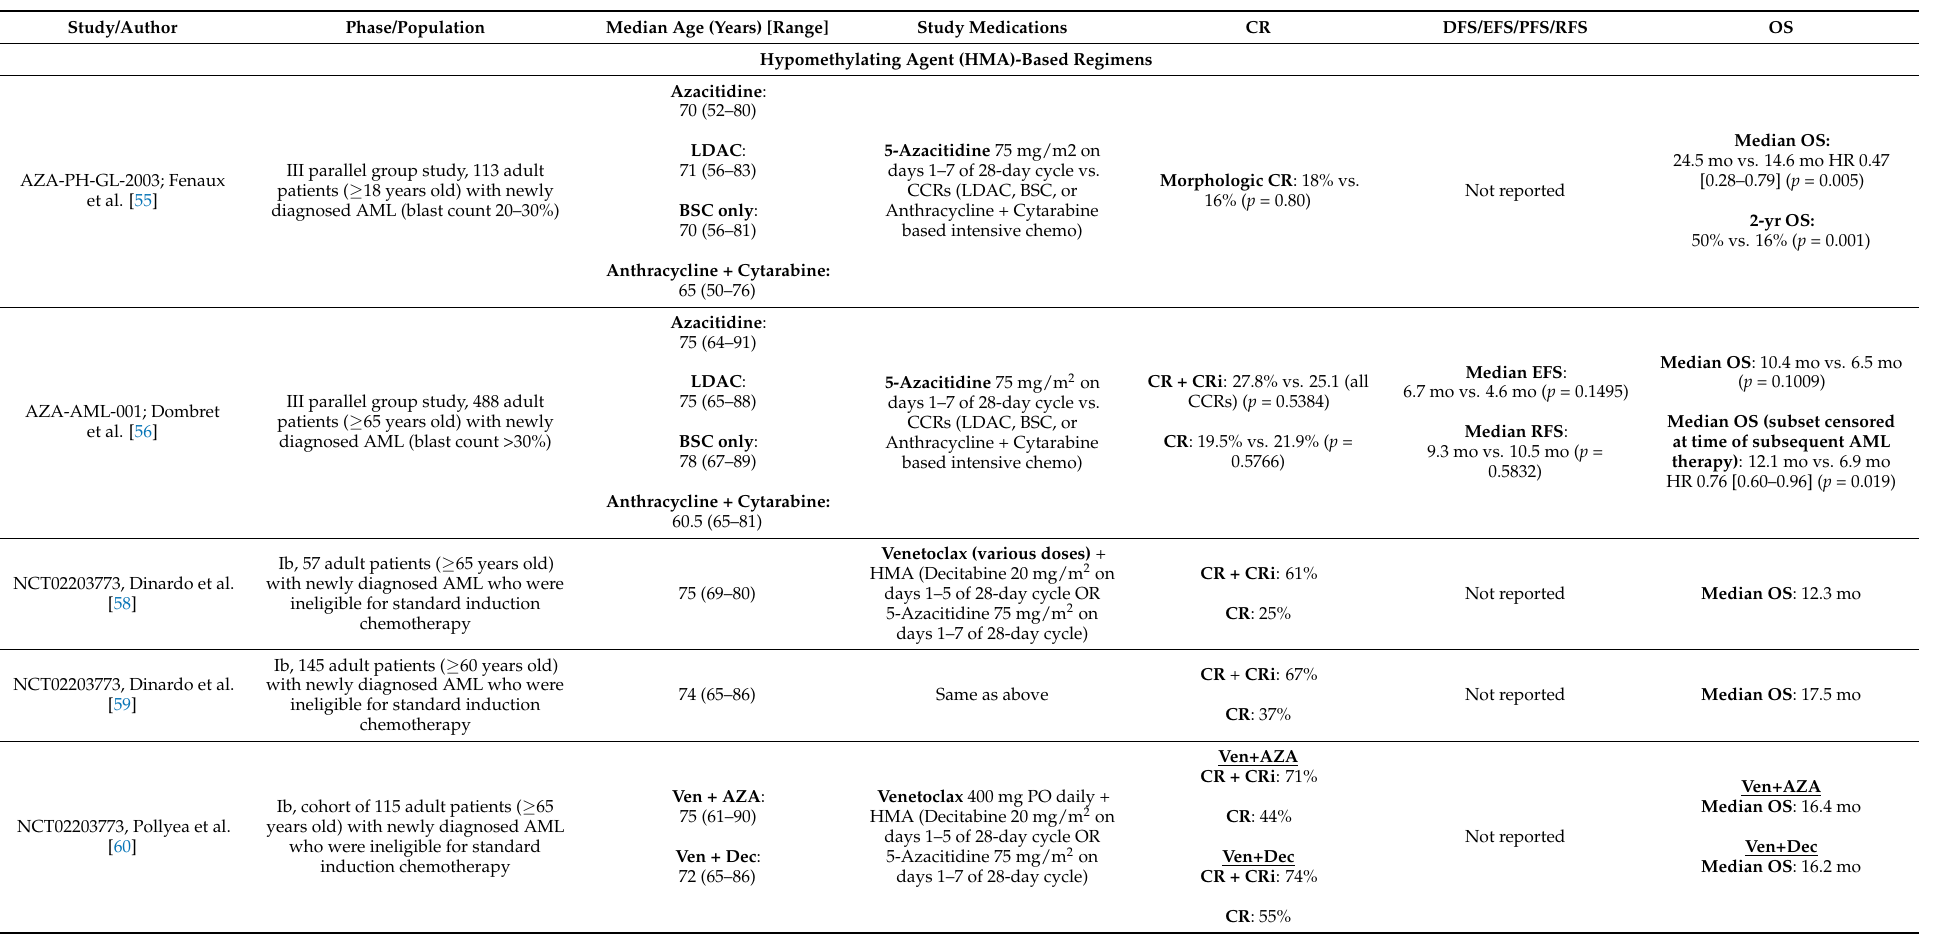
Table 2. Hypomethylator-based frontline regimens for adults with Acute Myeloid Leukemia with an emphasis on older